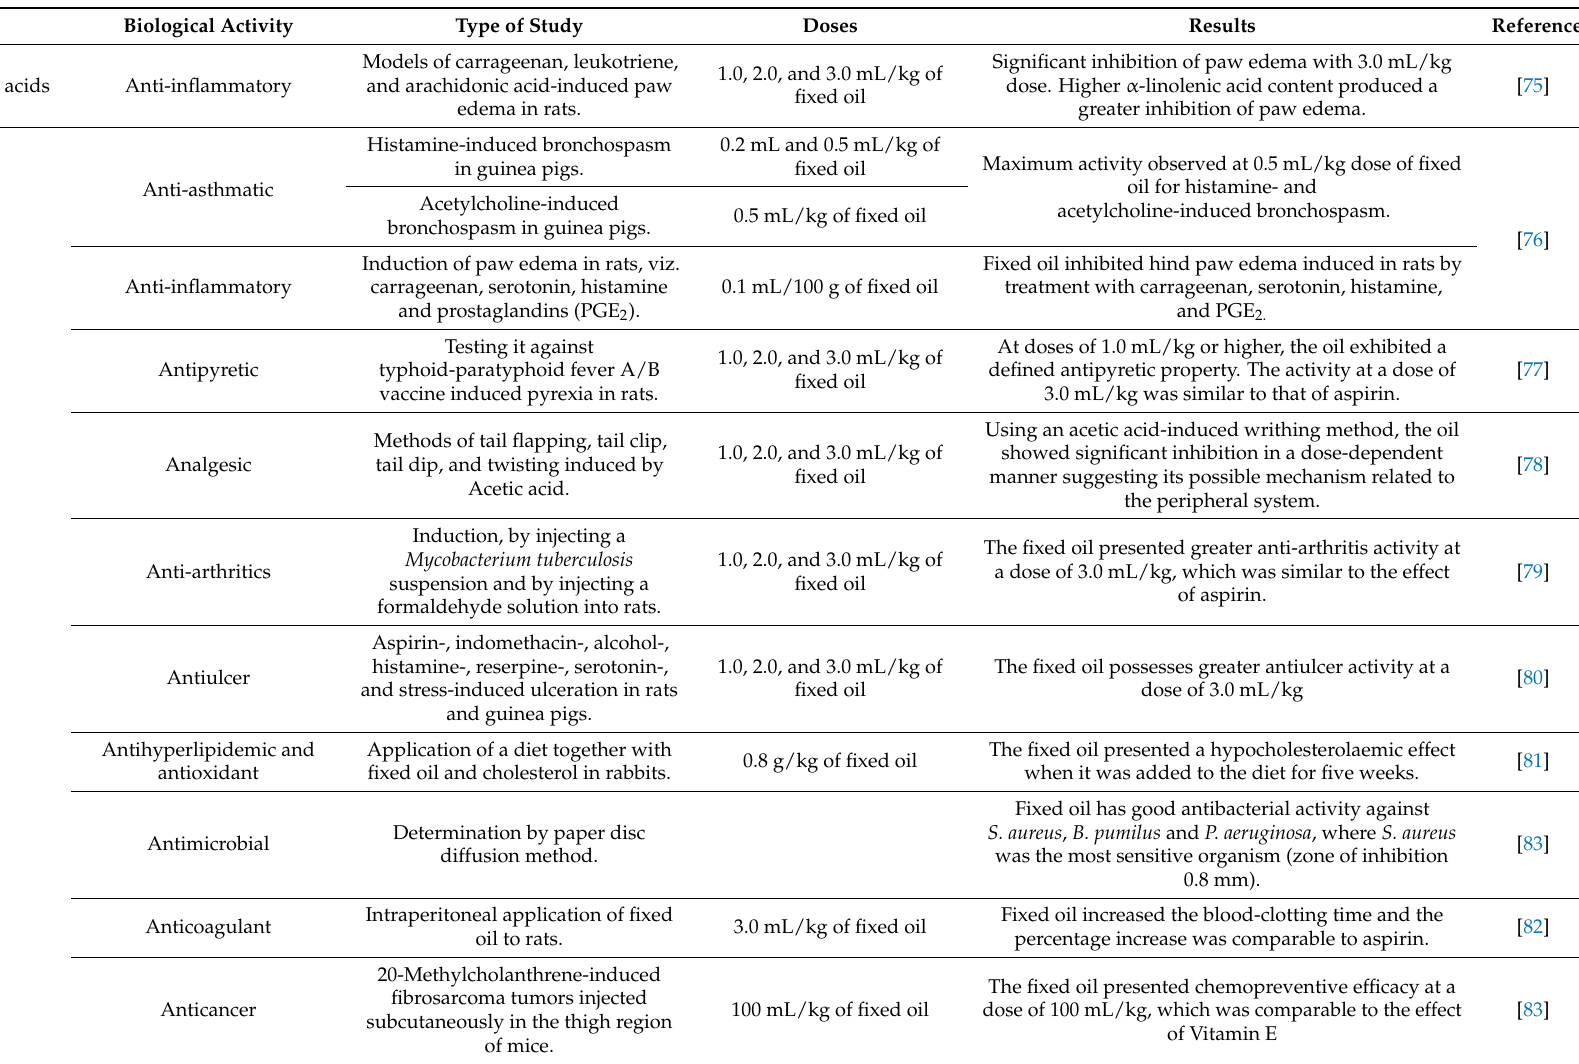
Table 7. Summary of the biological activity of basil seeds and their